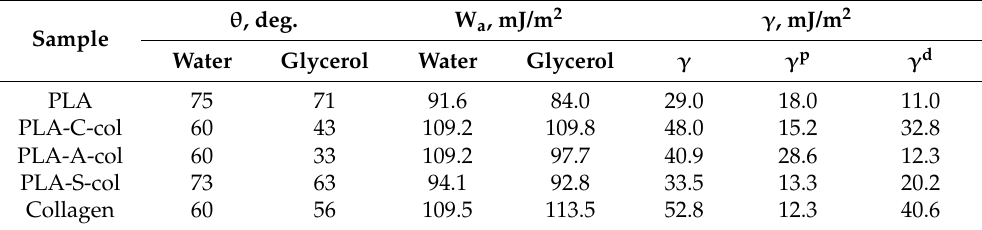
Table 4. Surface contact properties of the initial and collagen-coated PLA films and the collagen film.